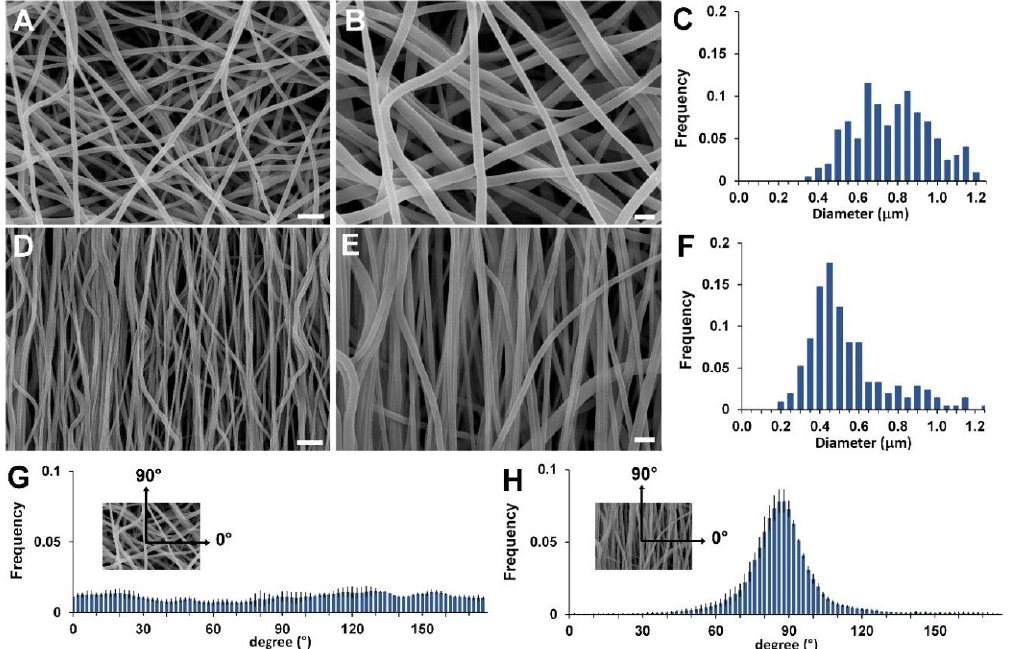
Figure 2. SEM images of RND scaffold ( A , B ) and ALN scaffold ( D , E ). Fiber diameter distribution of RND sca ff old ( C ) and ALN sca ff old ( F ). Fiber orientation distribution of RND sca ff old ( G ) and ALN RND scaffold ( C ) and ALN scaffold ( F ). Fiber orientation distribution of RND scaffold ( G ) and ALN sca ff old ( H ). Scale bars: A and D = 5 µ m; B and E = 2 µ scaffold ( H ). Scale bars: A and D = 5 µm; B and E = 2 µm.